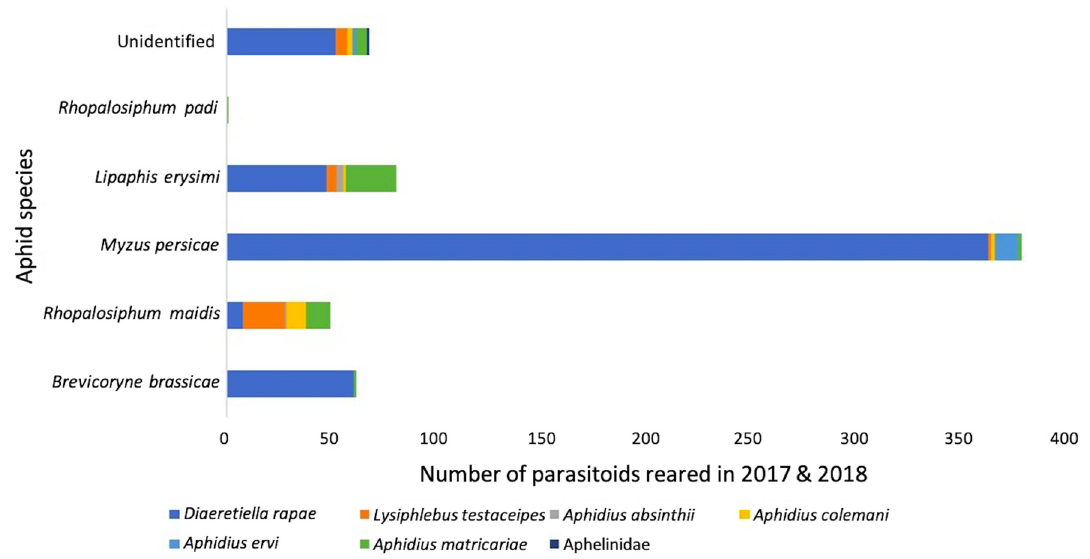
Figure 7. Primary parasitoid species composition of aphid species from fields and surrounding vegetation in 2017 and 2018, reared from mummies collected directly sampled for two